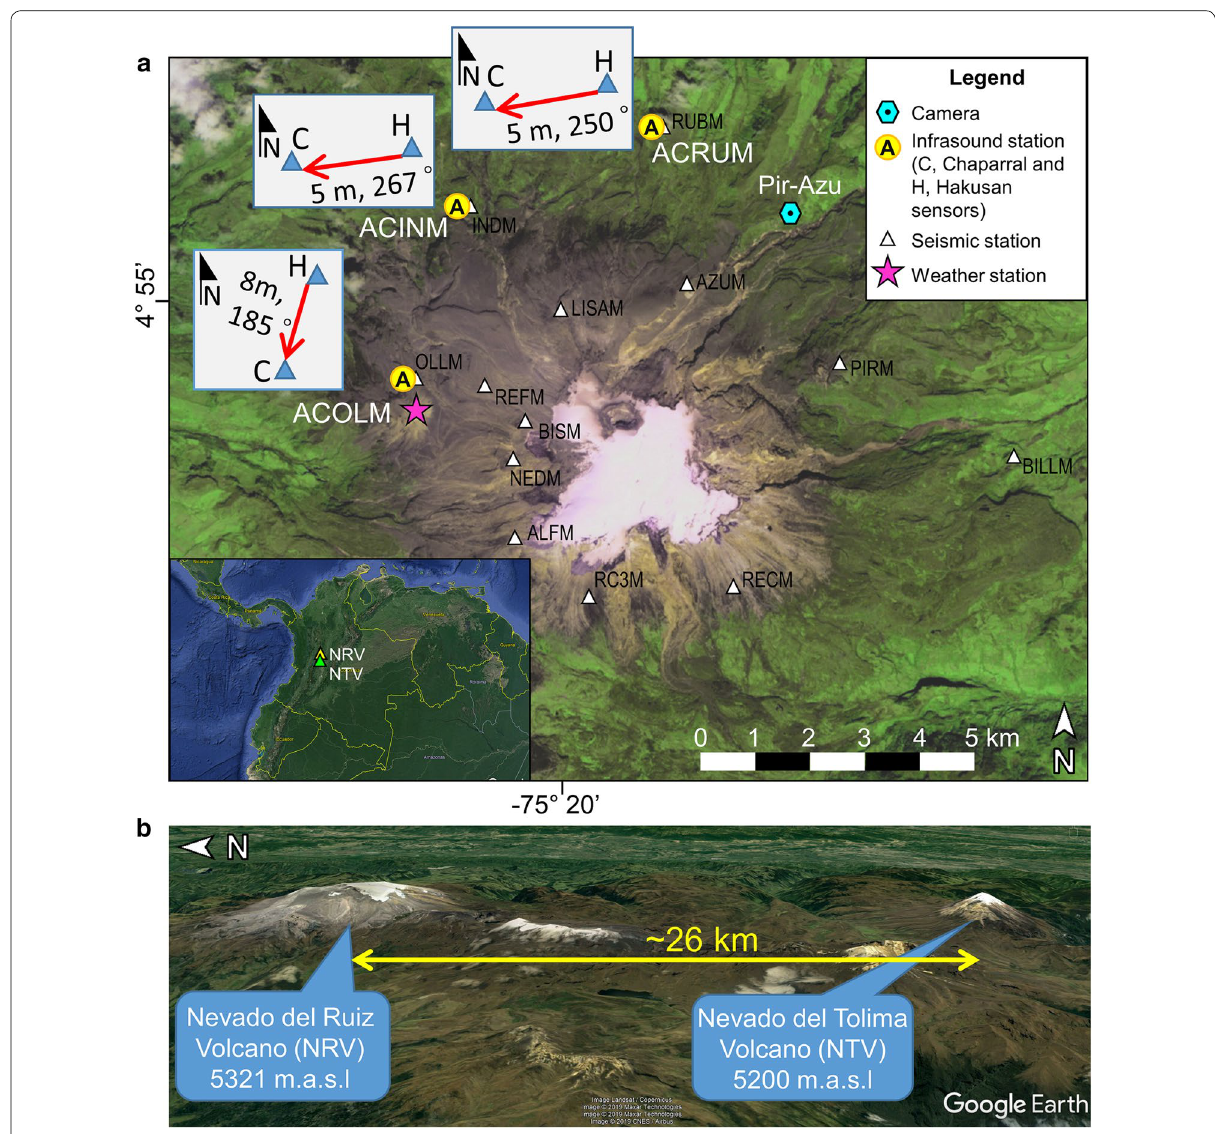
Fig. 1 Map of the location of Nevado del Ruiz volcano (NRV). a Monitoring network at NRV. The square boxes at three infrasound stations show the alignments of two infrasound sensors (a Chaparral 60Vx sensor at ‘C’ and a Hakusan SI104 sensor at ‘H’). The distances of the stations from the NRV crater are 4.2 km (ACOLM), 5.3 km (ACINM), and 6.0 km (ACRUM). b Location of Nevado del Tolima Volcano (NTV) close to NRV. The image sources are RapidEye Satellite image in 2010 for a , and Google Earth (Landsat/Copernicus with copyrights of Maxar Technologies and CNES/Airbus) for